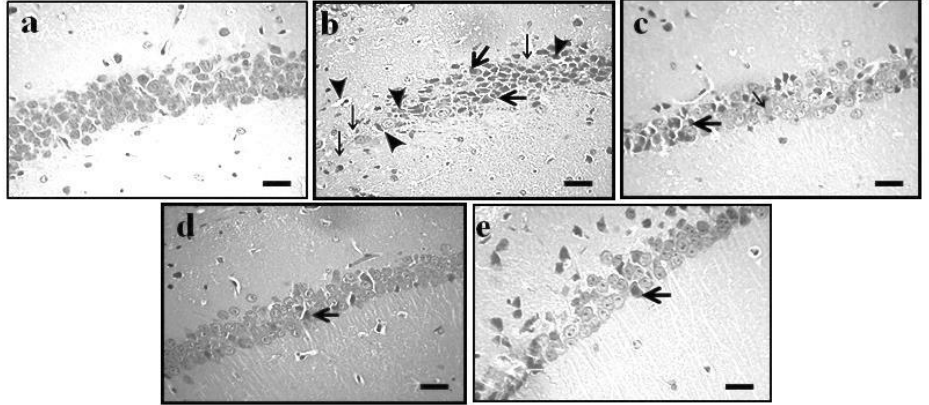
Figure 3. Effect of GE on AD-induced histopathological changes in CA1 region of the hippocampus. ( a – e ) Histopathological images of coronal sections of mouse brain tissue of normal, AD, and GE (2 and 4 mg/kg)- and DP (2 mg/kg)-treated groups, respectively. ( a ) Normal arrangement of pyramidal cells of the CA1 region and vesicular nuclei in hippocampus regions. The thin arrow shows neuron loss and neurofibrillary degeneration and neuronophagia, the thick arrow shows nuclear pyknosis, and the arrowhead shows vacuolation in the CA1 region of the hippocampus. ( b ) Typical colliquative necrosis, characterized by disrupted cell membranes, fragmented nuclei, and inflammatory cells, indicating that the Aβ oligomer caused neuronal structural pathological injuries in mice. ( c – e ) Reversal of Aβ 1–42 -induced histopathological changes. Microscopic examinations were performed under 400× light microscopy; scale bar = 35 μm.